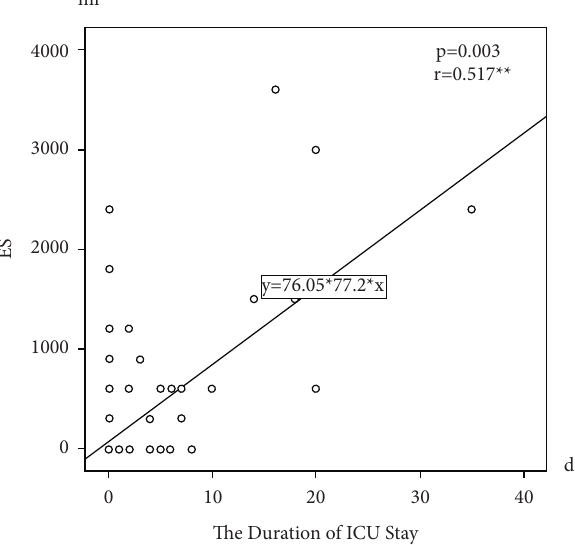
Figure 1: Relationship chart between erythrocyte suspension transfusion amount and length of stay in the intensive care